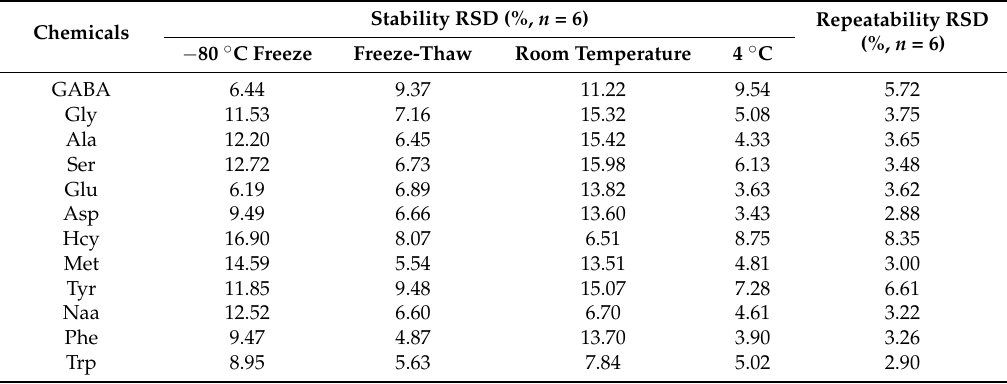
Table 4. Determination of amino acids by HPLC-MS/MS: validation results on stability and